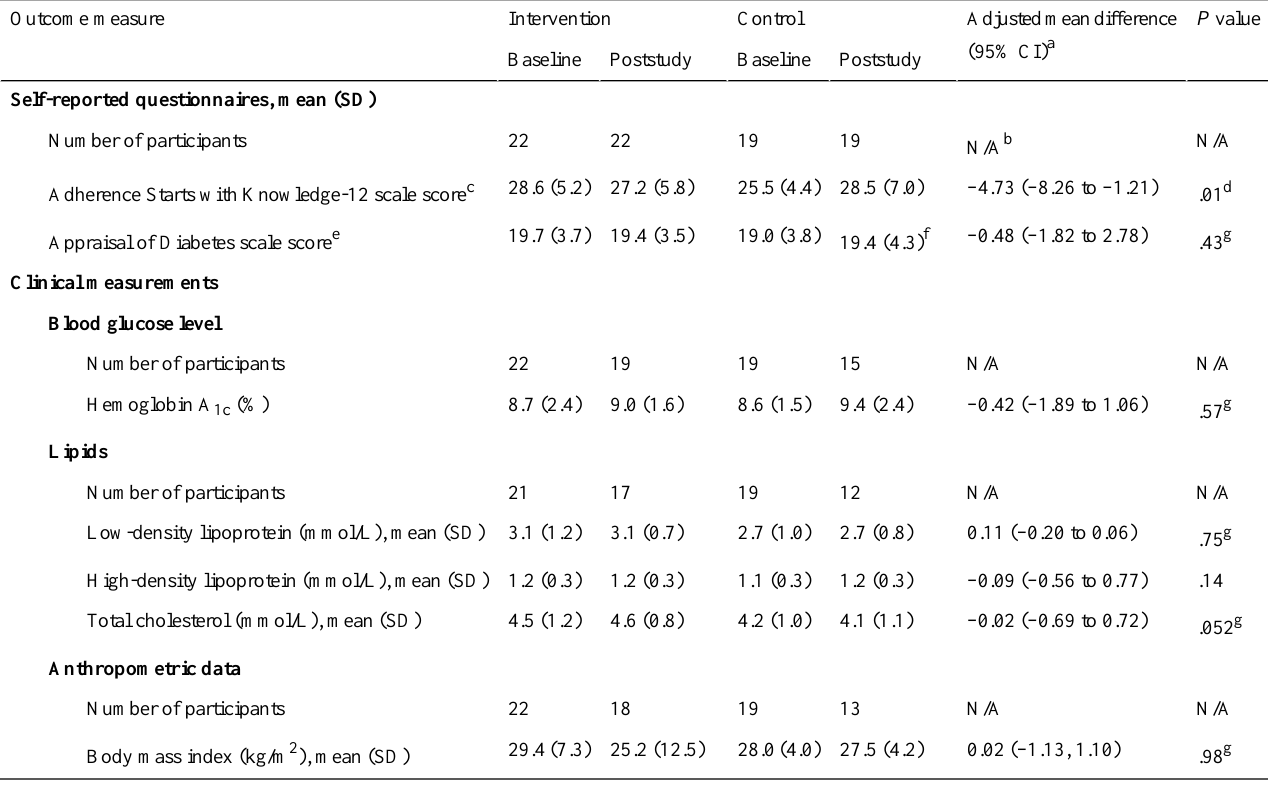
Table 2. Adjusted mean differences between treatment